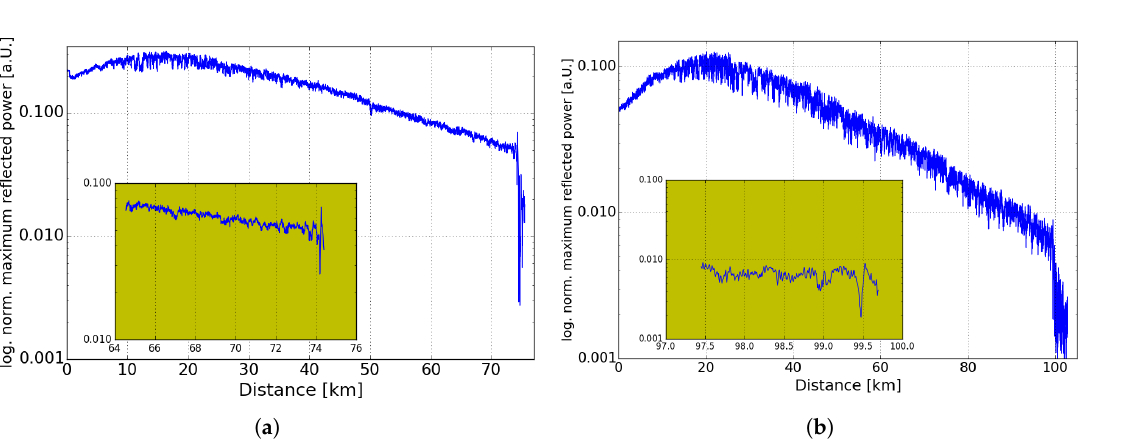
Figure 7. Logarithmized normalized maximum reflected power of the Brillouin gain spectrum (BGS) over distance of ( a ) 75 km sensing fiber with 20 ◦ C hotspot ( b ) 100-km sensing fiber with 30 ◦ C